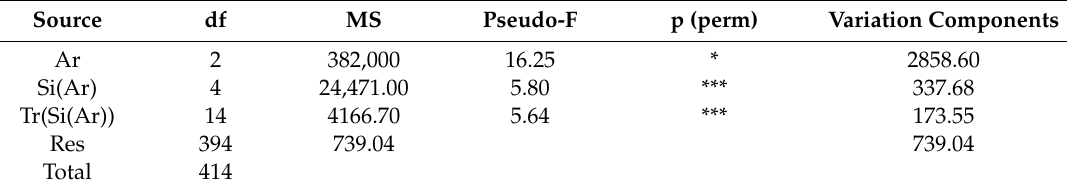
Table 3. Results of PERMANOVAs testing for spatial di ff erences in structure of algal assemblages at area (Ar), site (Si) and transect (Tr) scales, based on the algal cover percentage from ROV imaging. Analyses based on Bray-Curtis dissimilarities from untransformed data. Estimates of multivariate variation are given for each spatial scale. df = degrees of freedom; MS = mean sum of squares; Pseudo-F = F value by permutation; p (perm) = p -values based on 9999 random permutations of appropriate units. * p < 0.05; *** p < 0.001. Source df MS Pseudo-F